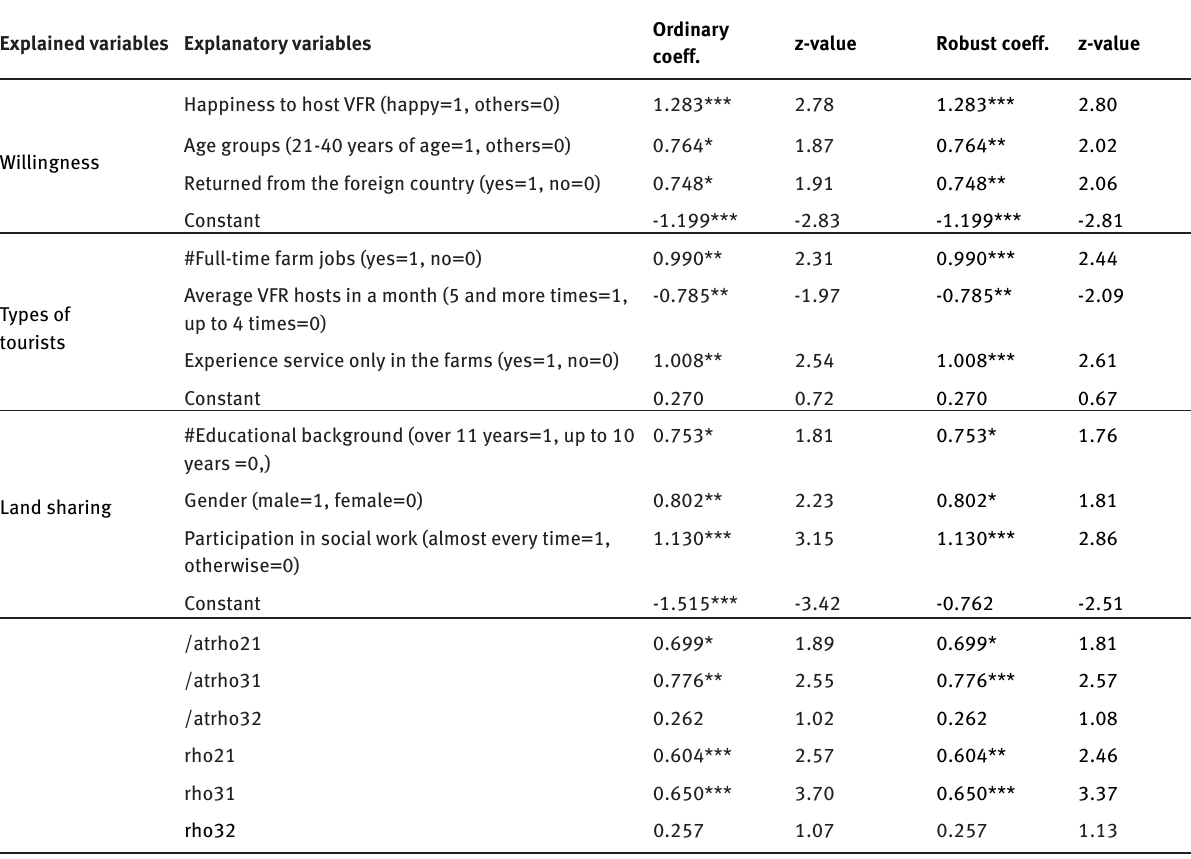
Table 5: Multivariate probit estimations for determinants of farmers’ willingness